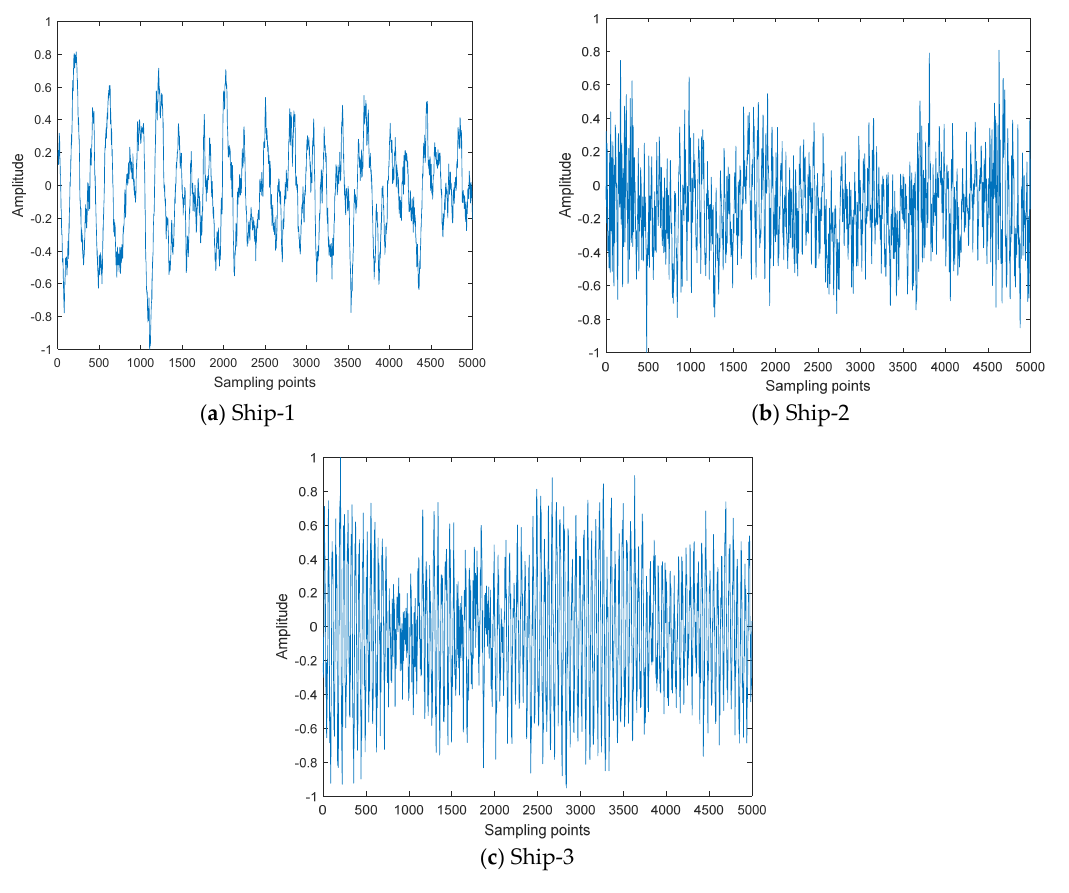
Figure 2. Three sorts of S-RN signals.